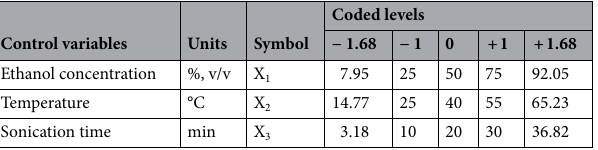
Table 1. Control variables, their coded values and actual values included in